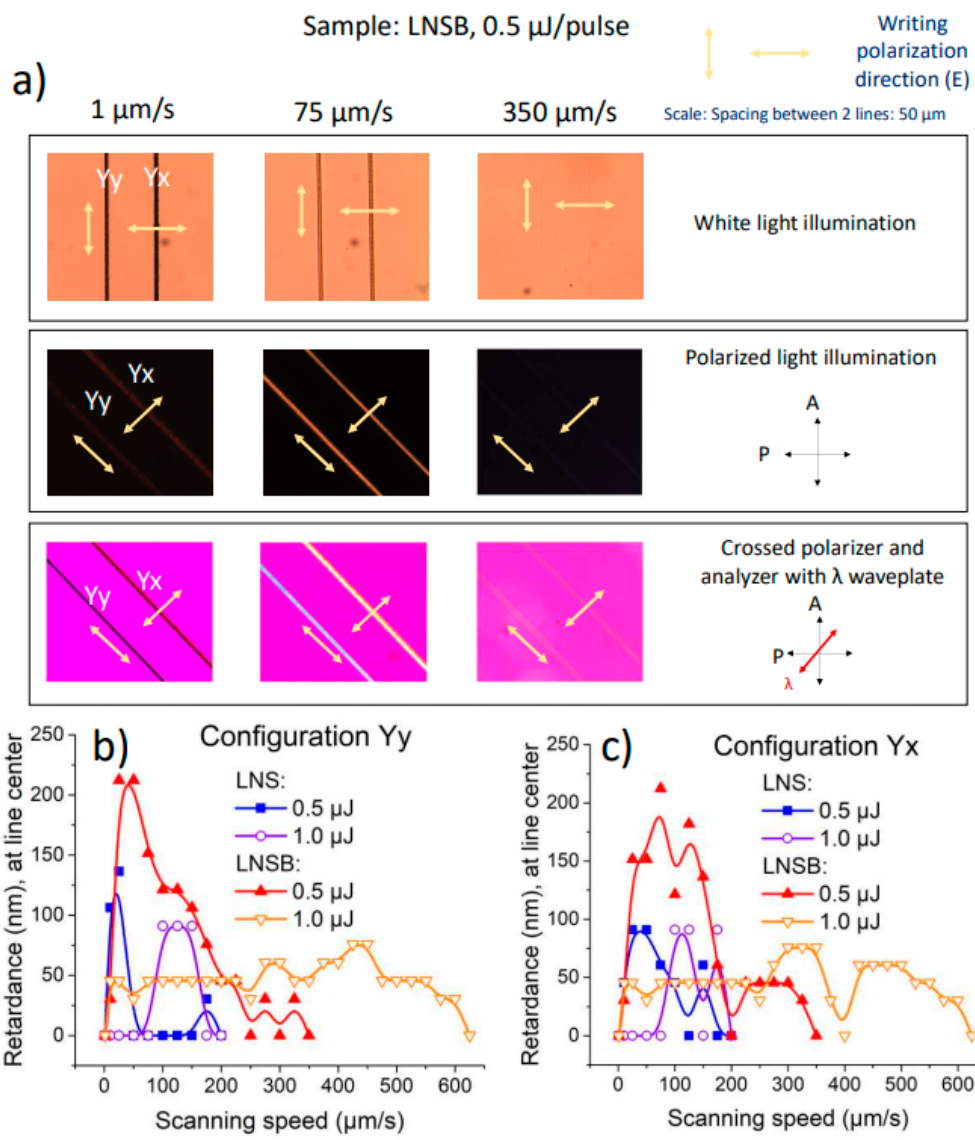
Figure 5. ( a ) Optical microscope images, under different illumination conditions, of lines written at different scanning speeds (1, 75, and 350 µm/s) for LNSB glass sample at a pulse energy of 0.5 µJ. P = polarizer; A = analyzer. Other (fixed) parameters are: λ (fs-laser wavelength) = 1030 nm; f = 200 kHz; NA = 0.6; pulse duration = 250 fs; focal depth: 240 µm (in air). Retardance (in nm) measured for ( b ) Yy and ( c ) Yx configurations at 550 nm at the center of the irradiated lines as a function of scanning speed, for both LNS and LNSB glasses, at pulse energies of 0.5 and 1.0 µJ.